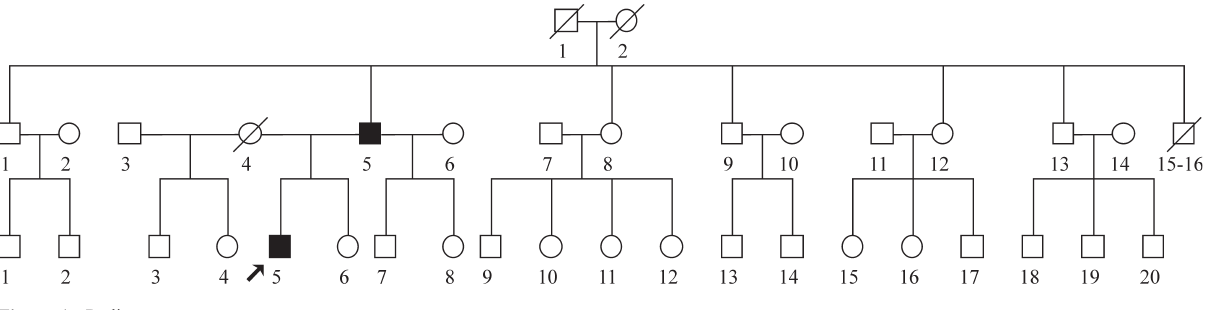
Figure 1 - Pedigree.